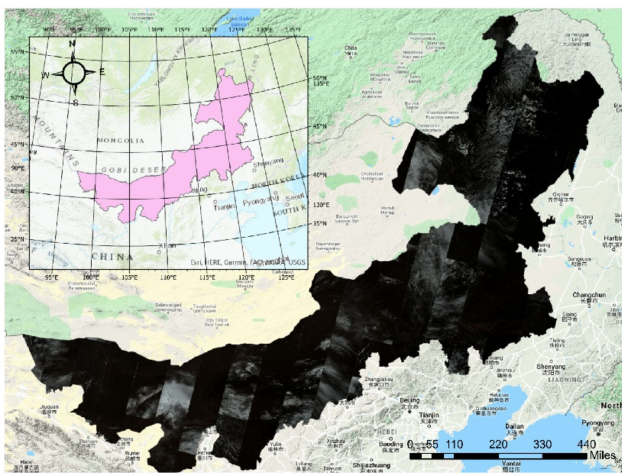
Figure 1. Landsat 8 OLI images at IMAR from August